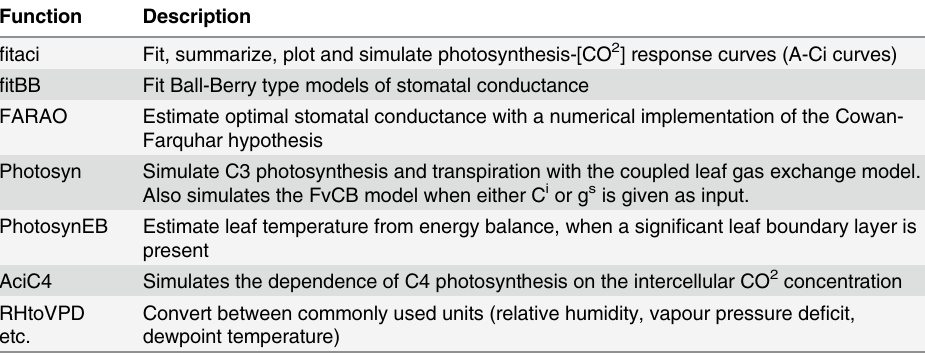
Table 1. Main functions in the plantecophys